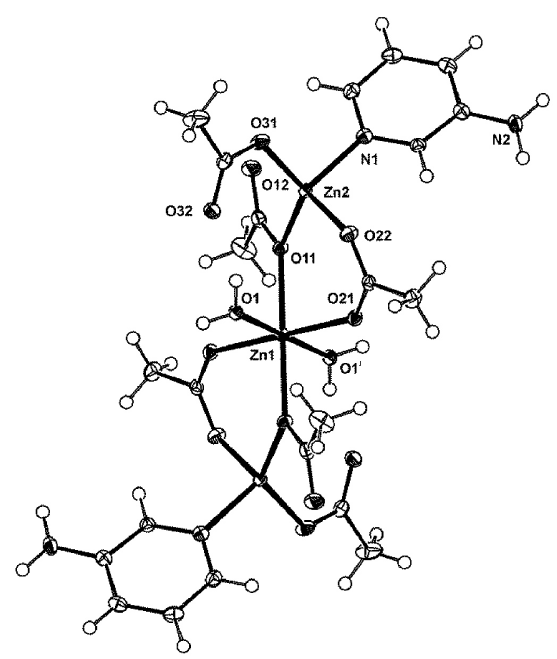
Figure 2. A view of 1 showing the atom-labelling scheme for non C and H atoms. Symmetry code: (i) – x + 1, – y + 1, – z + 1.